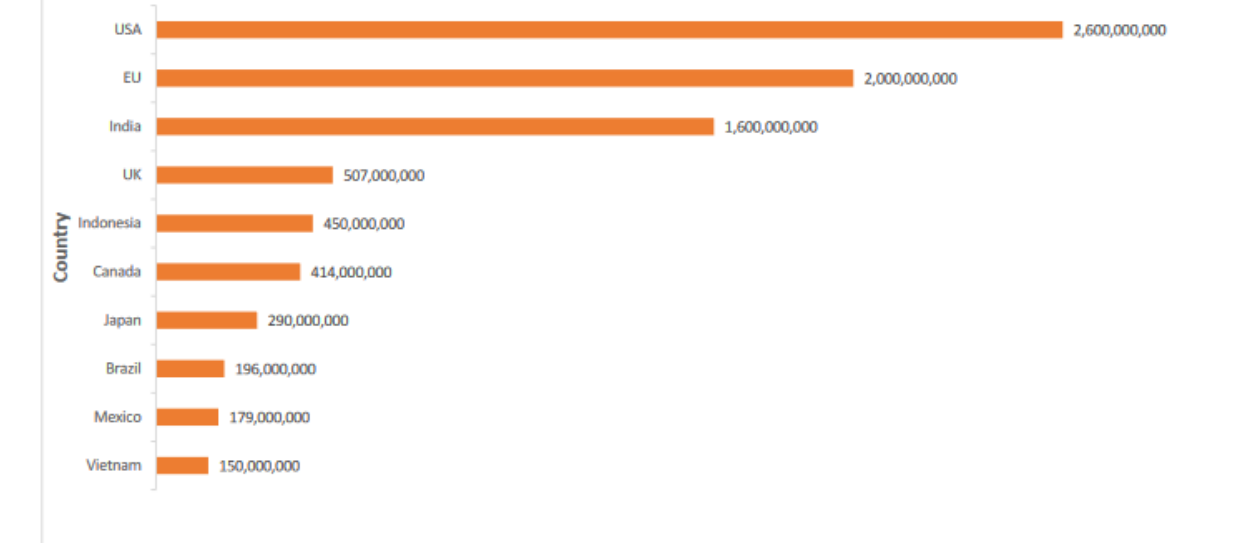
Figure 2. Top ten countries with the largest number of COVID-19 vaccine doses ordered. Source: Compiled by the authors from a variety of sources including Airfinity, Launch and Scale Speedometer, NPR.org, and Oxfam International.